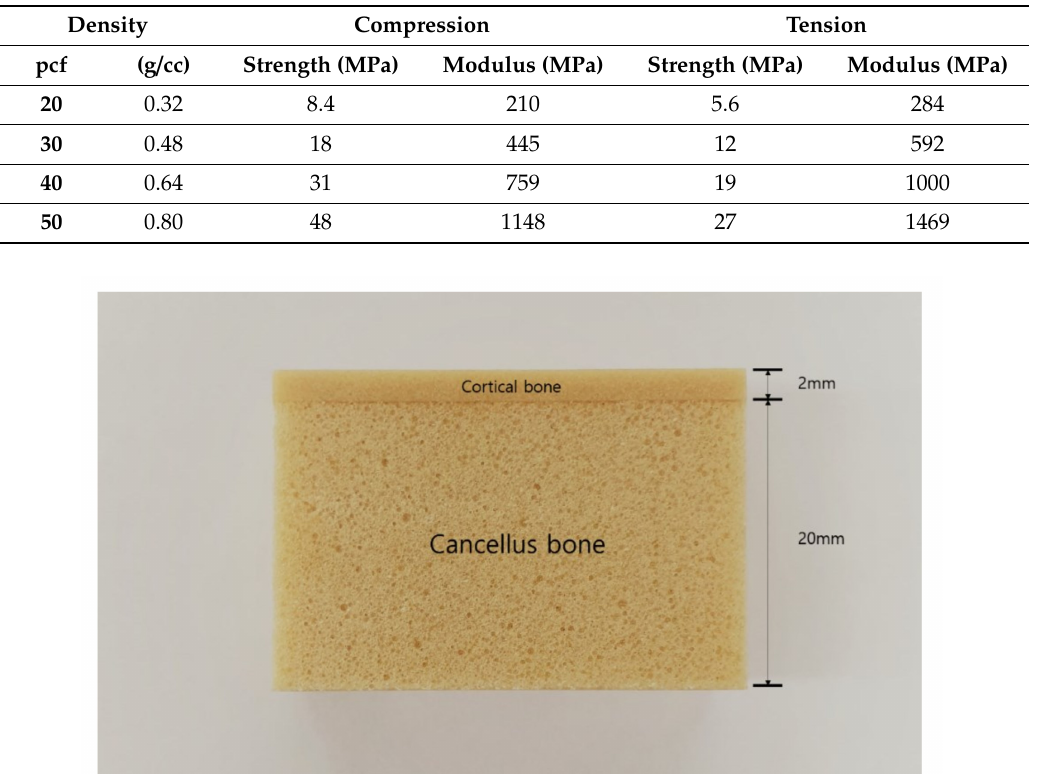
Table 1. Mechanical properties of the polyurethane foam bone blocks.